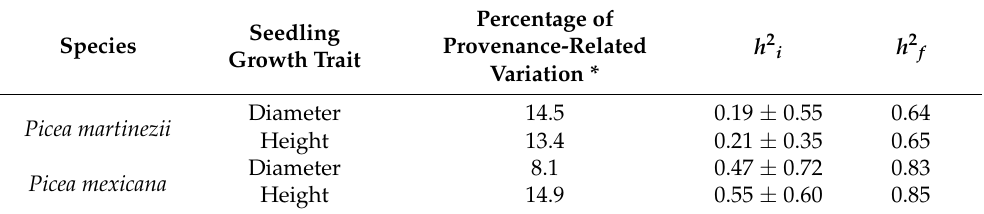
Table 7. Heritability (within-provenance) of seedling diameter and height (growth traits) in Picea martinezii and P. mexicana . Individual ( h 2 (* relative to total